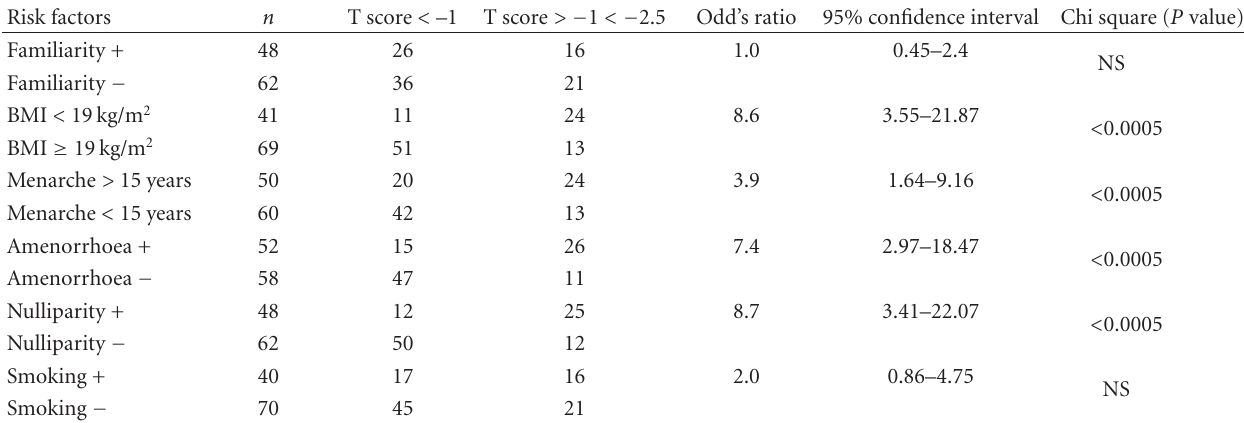
Table 3: Odd’s ratio of each risk